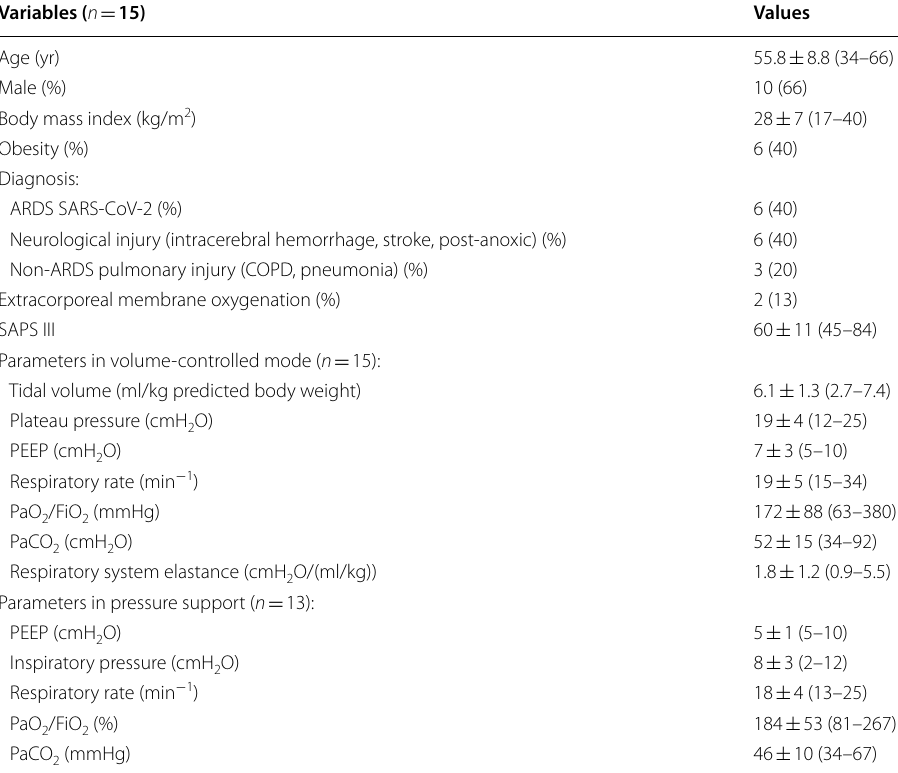
ARDS, adult respiratory distress syndrome; SARS‑COV‑2, severe acute respiratory syndrome—coronavirus‑2; COPD, chronic obstructive pulmonary disease; SAPS, Simplified Acute Physiology Score; PEEP, positive end‑expiratory pressure